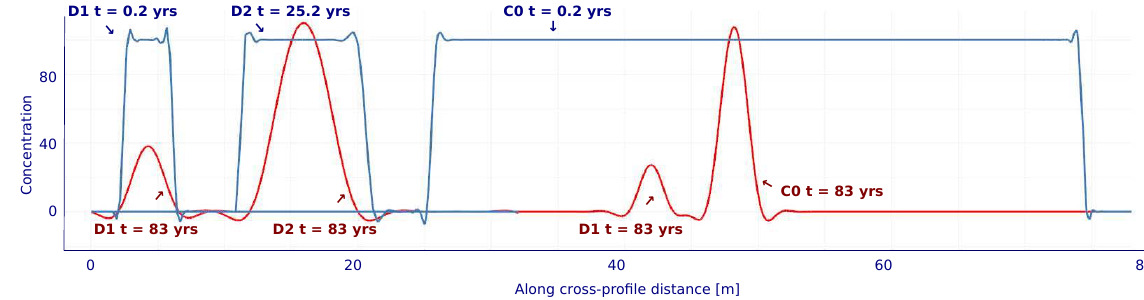
Figure 11. Vertical cross sections at different model times for debris features D1, D2 and CO from the 2-D glacier test (see Fig. 9). The verti- cal cross sections are taken at the initial feature geometries in blue and evolved feature geometries at the simulation end in red. Corresponding cross sections are centred at the same along cross-profile distance for ease of comparison. The vertical cross profiles are taken at a horizontal distance of 601 . 5m (D1, t = 0 . 2 years) and 3148 . 5m (D1, t = 83 years), 1100m (D2, t = 25 . 2 years) and 3270m (D2, t = 83 years), 502m (C0, t = 0 . 2 years) and 2062m (C0, t = 83 years). The exact location and orientation of the profiles is indicated in Fig.